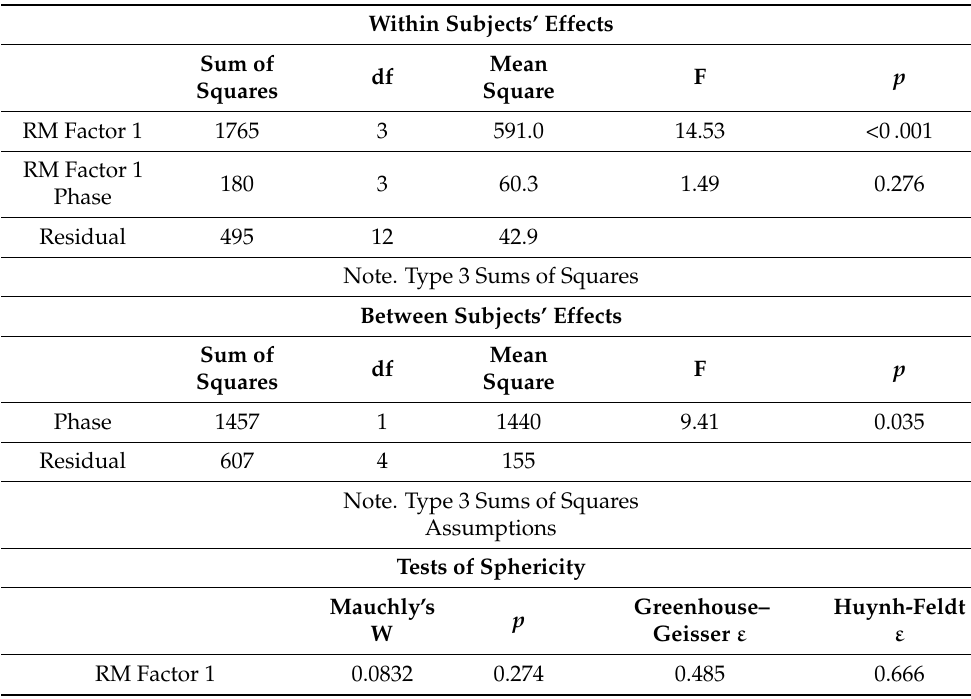
Table 2. Effect of AO (approach B) on volubility versus traditional speech-language therapy (approach A). Repeated measures ANOVA.